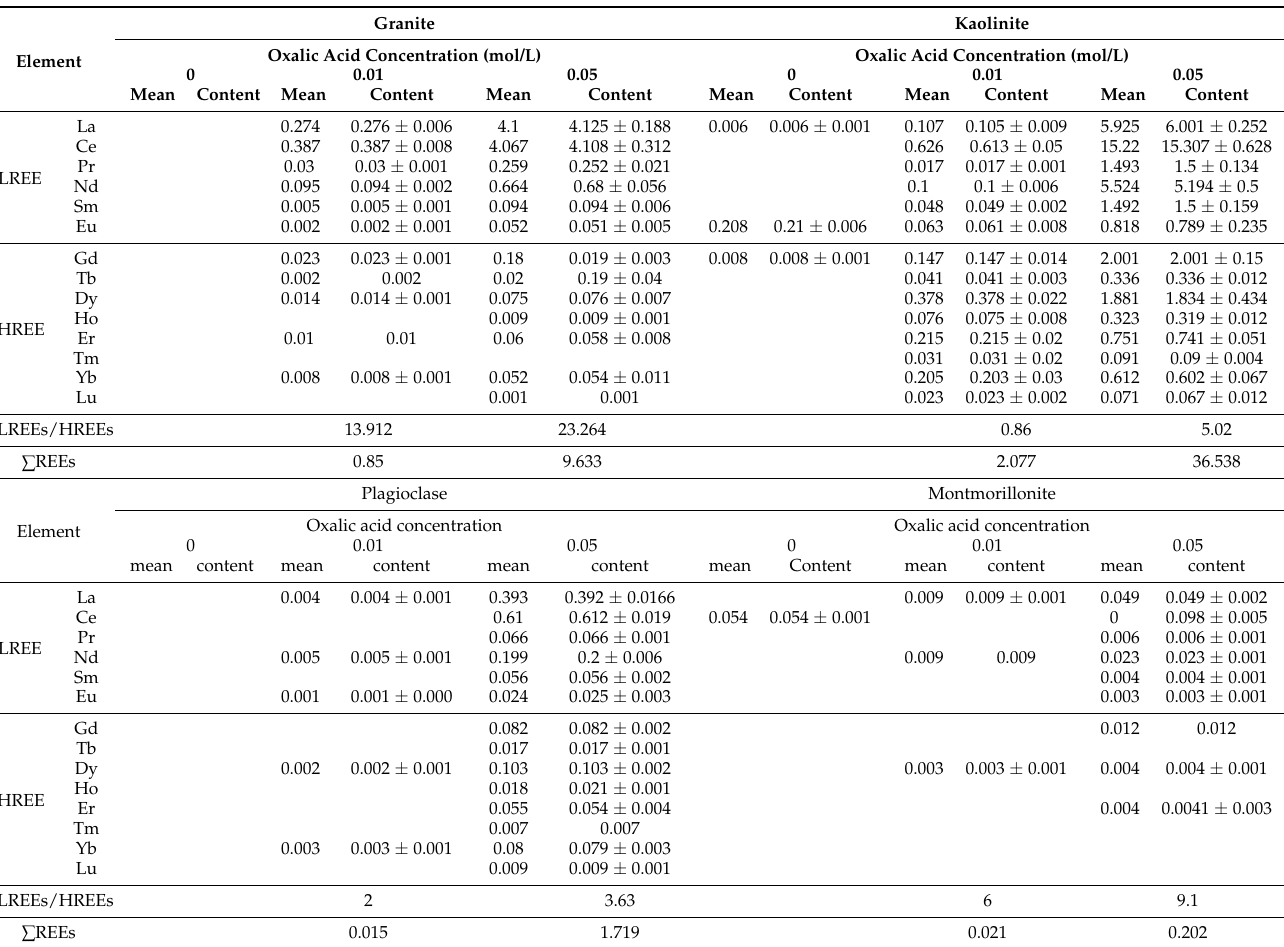
Figure 3. Dissolved LREEs and HREEs from minerals in oxalic acid leachates. ( a ) 0.01 mol/L oxalic acid leachates; ( b ) 0.05 mol/L oxalic acid leachates. The red error bar is the standard deviation of HREE, and the black error bar is the standard deviation of LREE. Table 3. Contents of REEs in the oxalic acid leachates ( µ g/L).